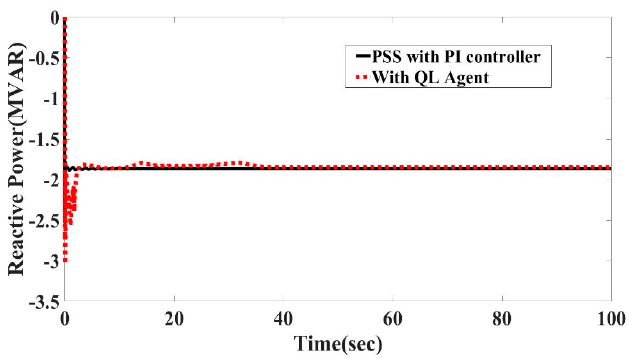
Figure 25 . Reactive power with PI controller vs. Q ‐ learning.